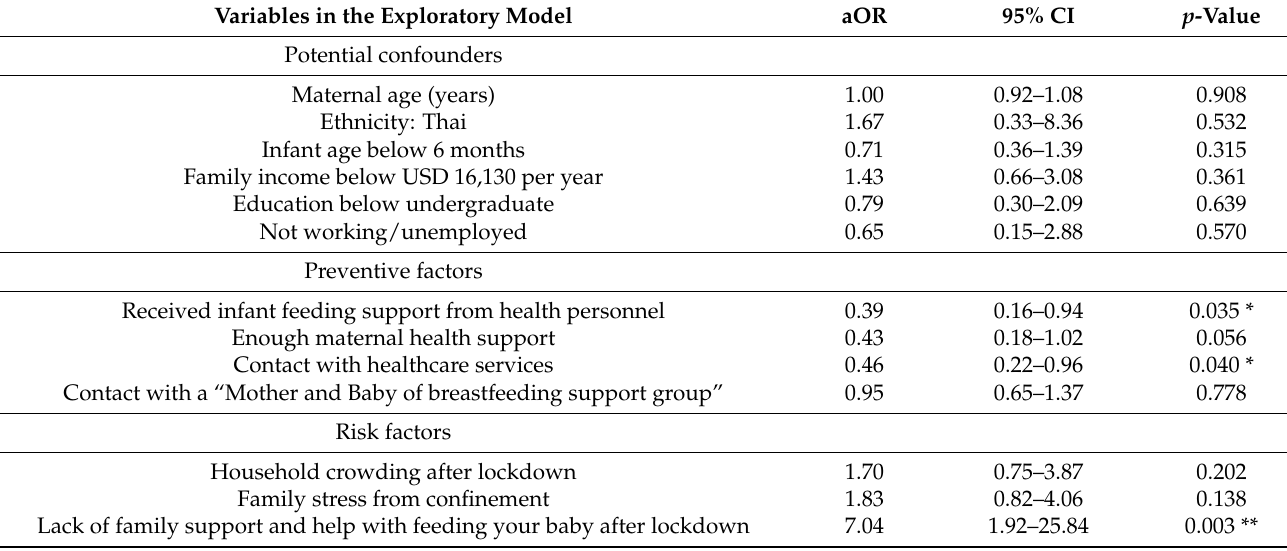
Table 3. Full exploratory model of the associated factors of changing breastfeeding practices using multivariable logistic regression. Variables in the Exploratory